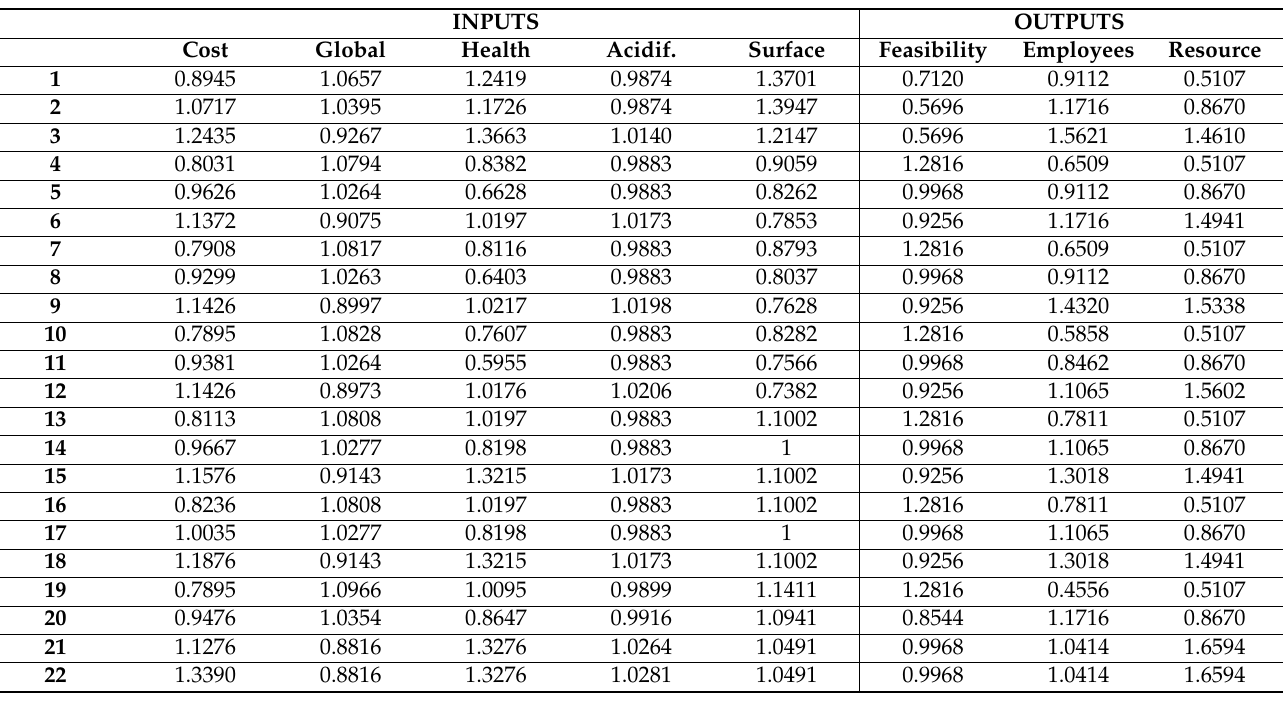
Table 1. Normalized data of [22].